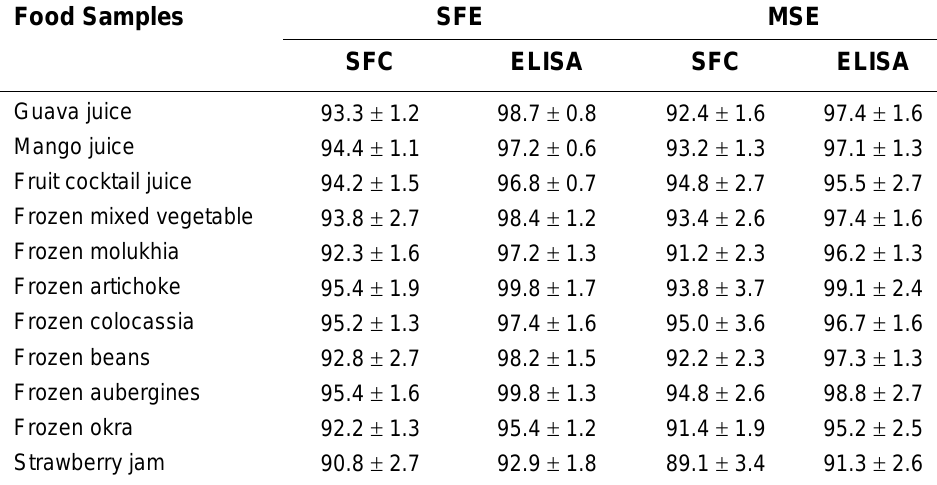
Atrazine Recovery and RSD Percentages of Spiked Food Samples Extracted by SFE and MSE, Determined by SFC at 220 nm and ELISA Technique at 450 nm